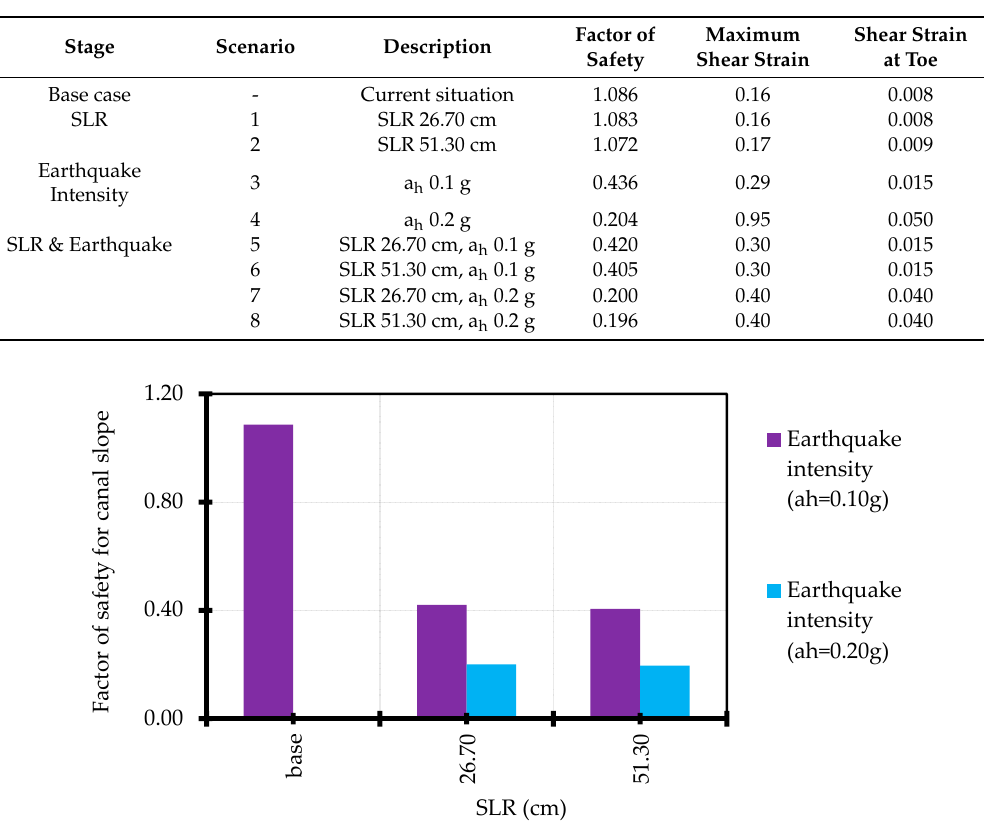
Table 2. Maximum shear strain for different scenarios.